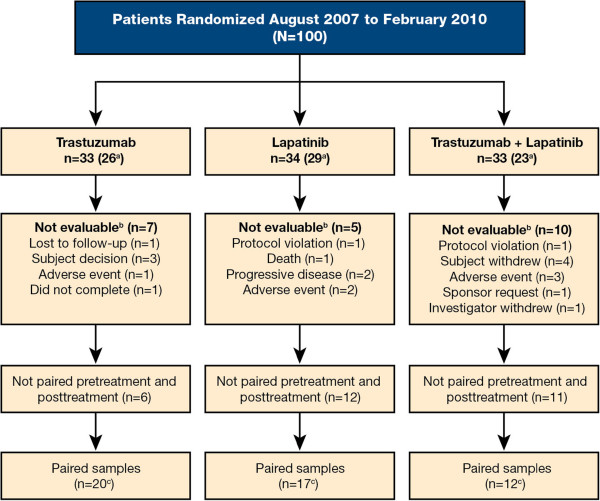
CONSORT diagram. aPatients who had surgery; bPatients with inevaluable tumor responses; cPatients who had surgery and had paired biopsies for evaluation.